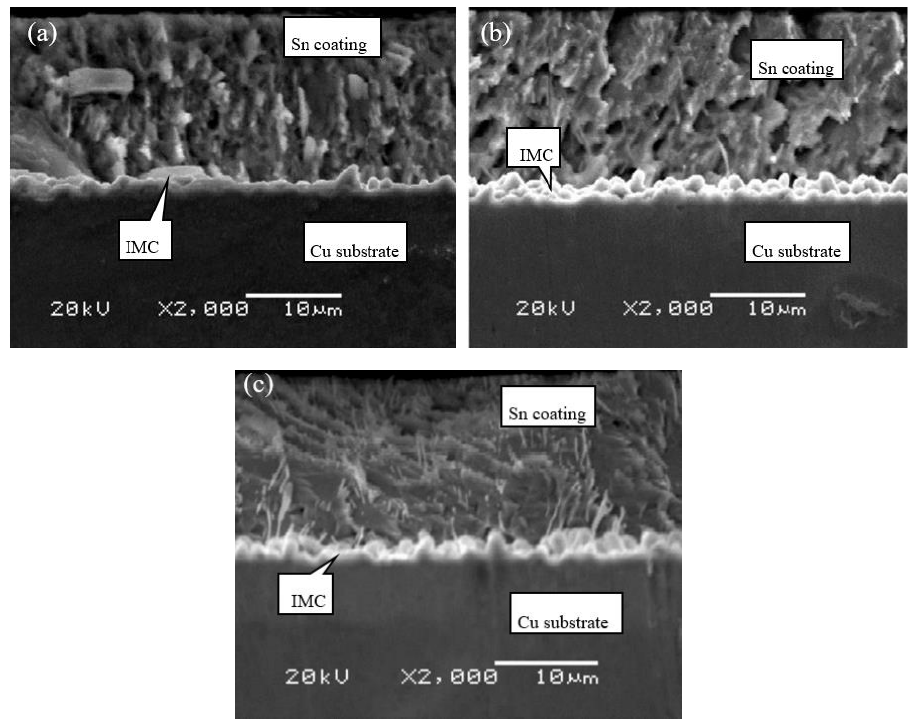
Figure 8. Cross-sectional microstructure of C19400 foils coated at 280 °C with different dipping time: ( a ) 4 s, ( b ) 8 s, and ( c ) 16 s.